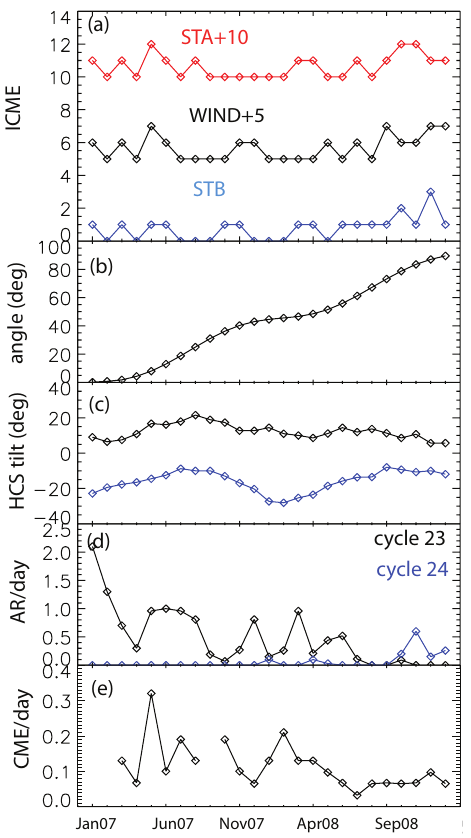
Fig. 1. Comparison of monthly ICME rate and solar activity from January 2007 to January 2009. The panels show (a) number of ICMEs each month, (red) STA, (blue) STB, (black) Wind, (b) an- gular separation between the STEREO spacecraft, (c) the maximum northern (black) and southern (blue) extent of HCS from Wilcox Solar Observatory, (d) the average number of solar cycle 23 active regions (black) and solar cycle 24 active regions (blue) visible at the Sun per day as reported in NOAA/USAF Active Region Sum- maries, and (e) the monthly average of the STA daily CME rate for events with angular width > 50 ◦ from the CACTus